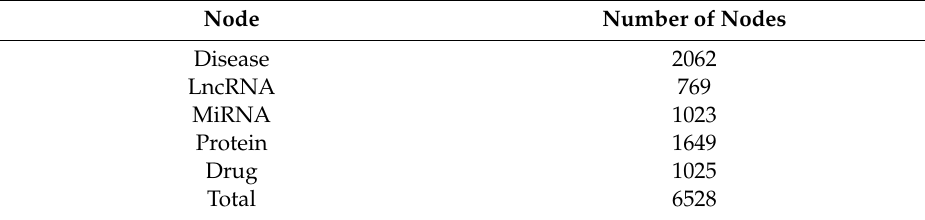
Table 2. The amount of five types of nodes in the molecular association network